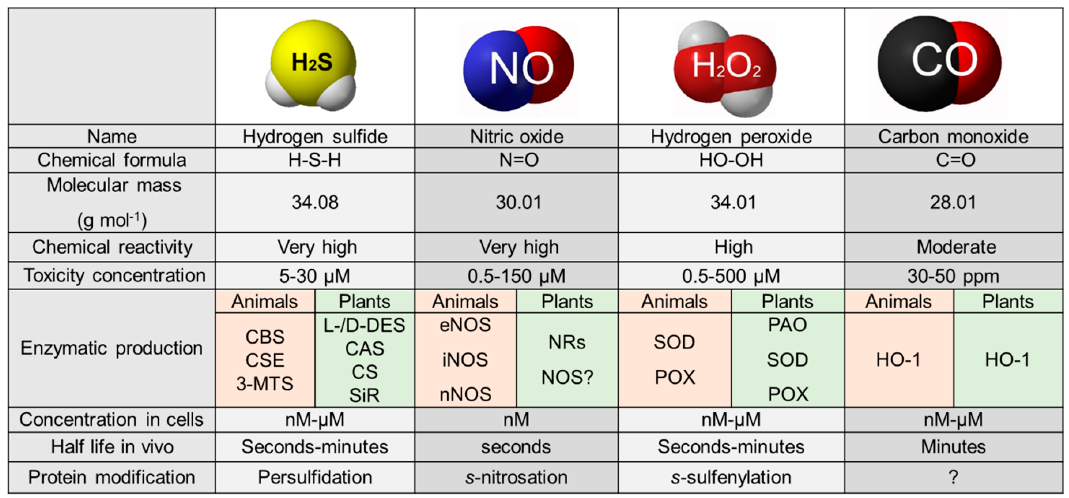
Figure 1. Comparison of signaling molecules in plants and mammals. Hydrogen sulfide (H 2 S), nitric oxide (NO), hydrogen peroxide (H 2 O 2 ) and carbon monoxide (CO) are considered to be signaling molecules in diverse and important physiological pathways in cells. These inorganic molecules are endogenously produced by enzymatic pathways and have similar molecular masses but different chemical reactivity.